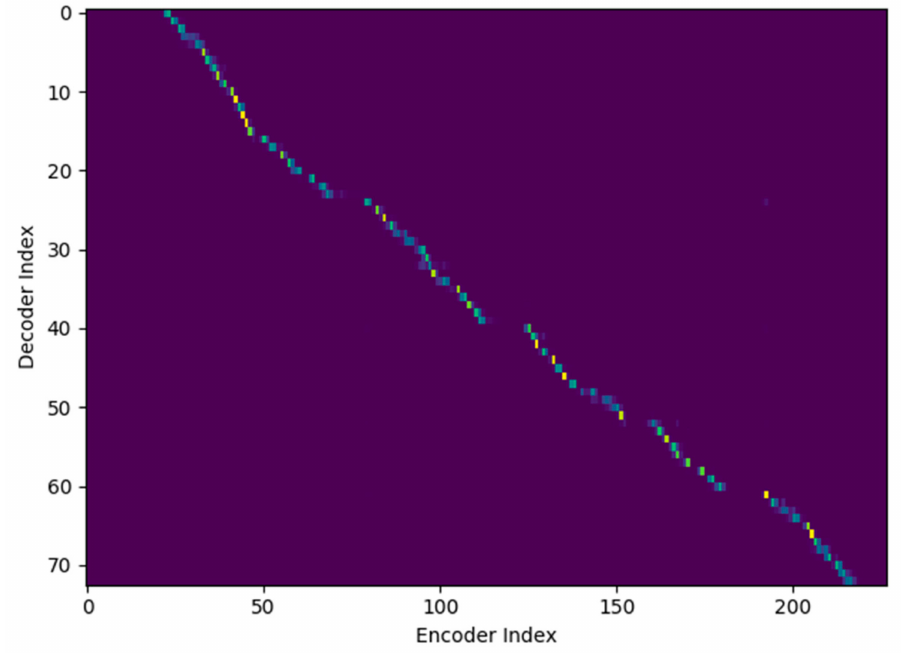
Figure 7. A phoneme‑based alignment index in the CTC‑attention model at the 20th